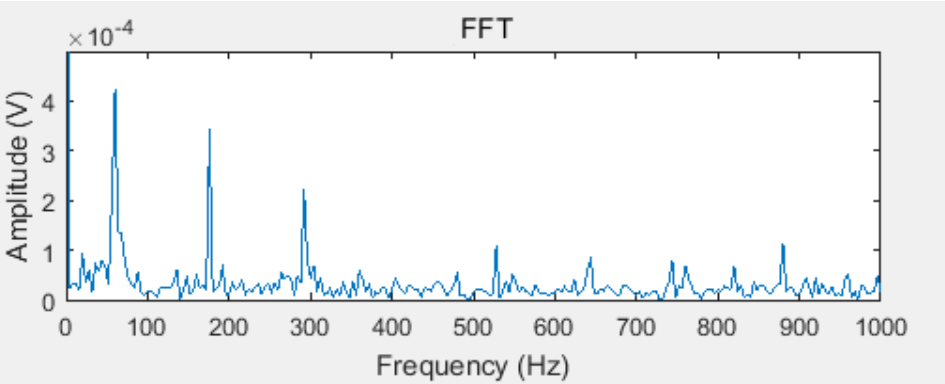
Figure 5. The Fourier transform spectrum of original signal.